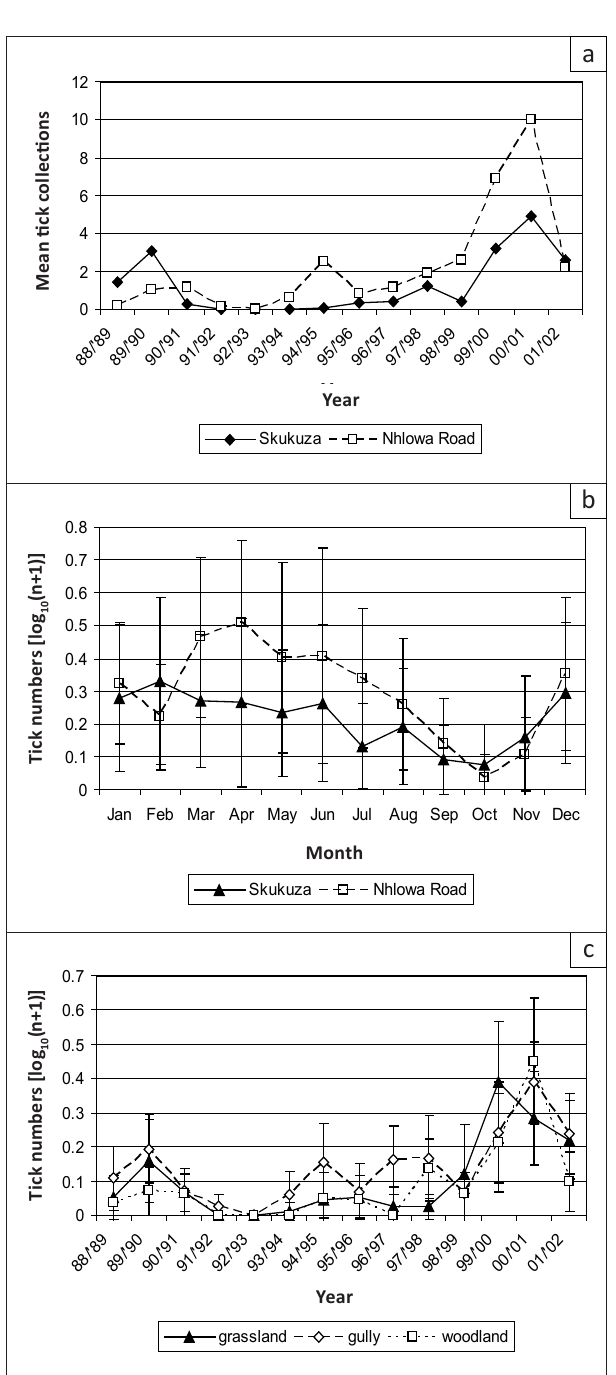
FIGURE 3: (a) Mean monthly collections of Haemaphysalis elliptica adults from each site per year, (b) mean collections (± 95% confidence interval) per month from each site and (c) mean collections (± 95% confidence interval) from each habitat per